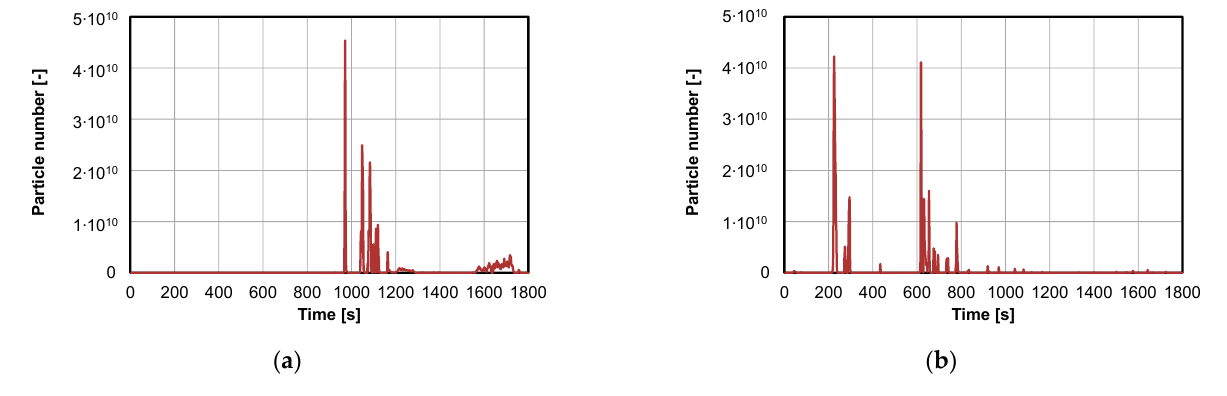
Figure 22. The PN versus time for: ( a ) plug-in; ( b ) HEV.